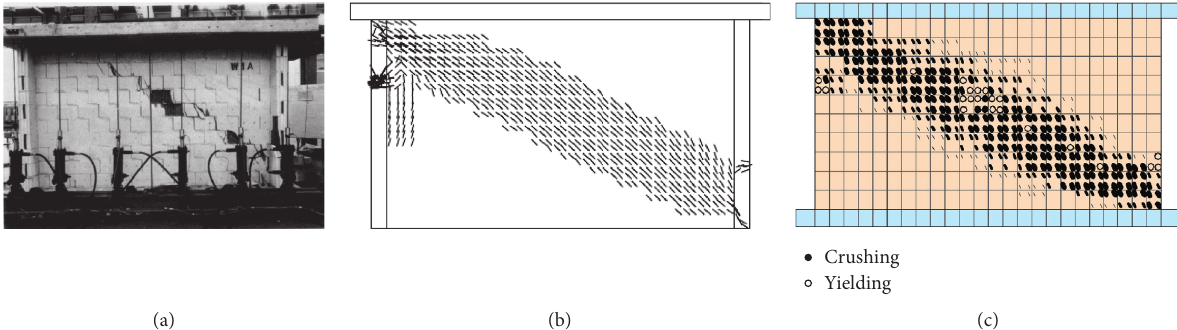
Figure 5: Crack patterns for wall W1 at a displacement of 12mm: (a) experiment [27]; (b) numerical results [28]; (c) presented numerical model.